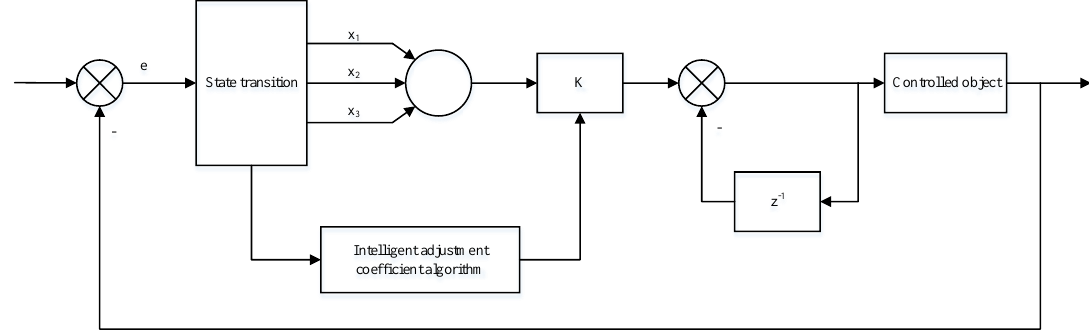
Figure 8. Single neuron adaptive PID control structure.